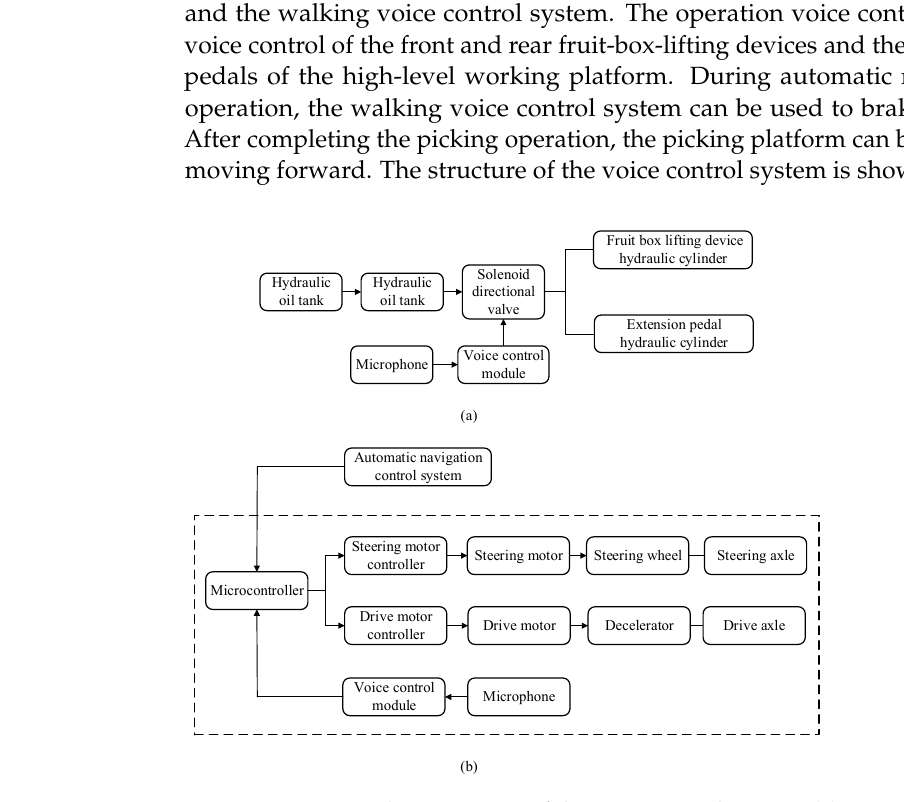
Table 3. Ba tt ery main parameter.